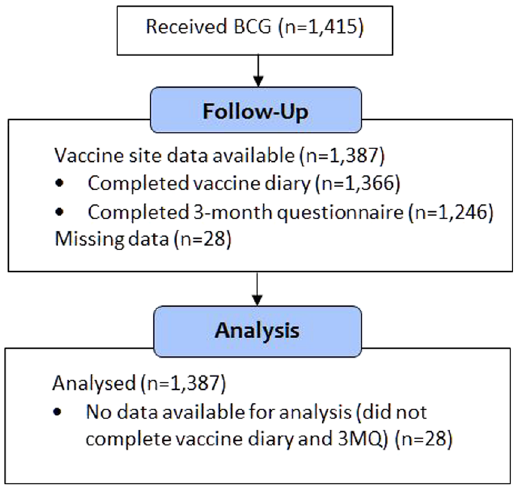
Fig. 1 BRACE stage 1 participants who received BCG. BCG Bacille Calmette-Guérin, 3MQ 3-month